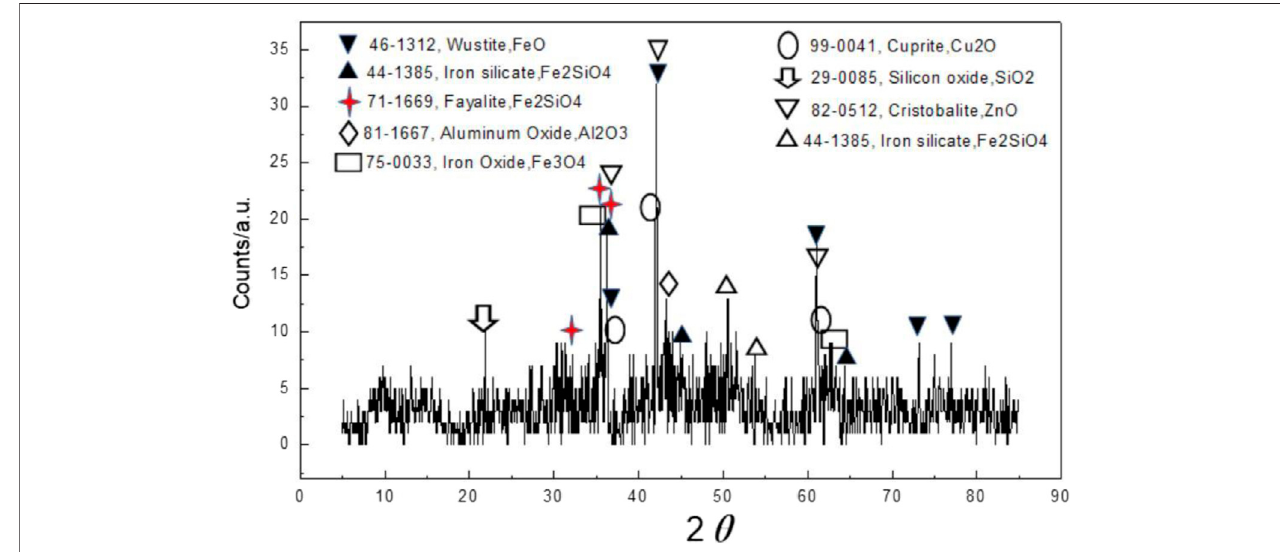
FIGURE 1 | XRD analyzed results of initial copper